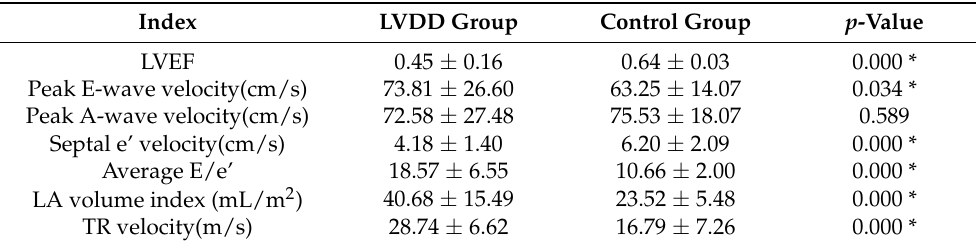
Table 1. Some Doppler echocardiography indices (mean ± standard